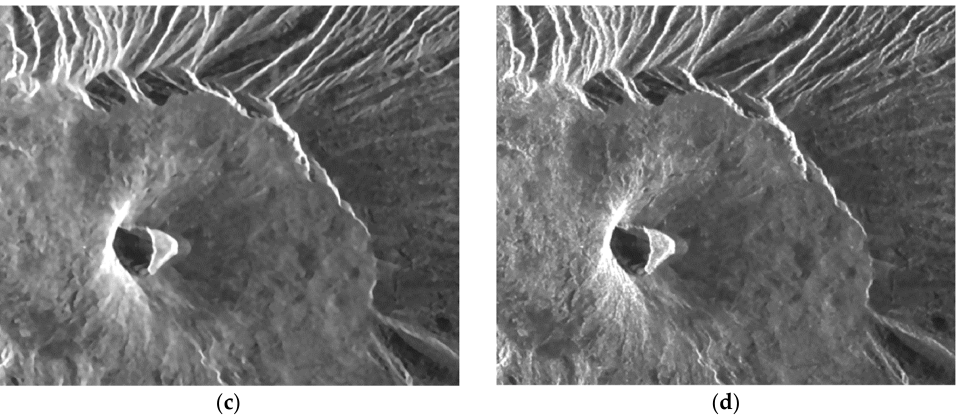
Figure 18. ( a ) 1950 × 2430 stripmap SAR image used as input with 10 × 10 spatial multilook. Vesuvius is at the center and Monte Somma is visible behind. The red box highlights the region where the coefficient of variation is evaluated: the reference value computed on the single-look image is Cx = 0.996. ( b ) Local range slope map. Despeckled image using ( c ) PPB with four iterations (Cx = 0.851, RT = 994 s), ( d ) SB-PPB with incidence angle estimated by SfS (Cx = 0.897, RT = 293 s).